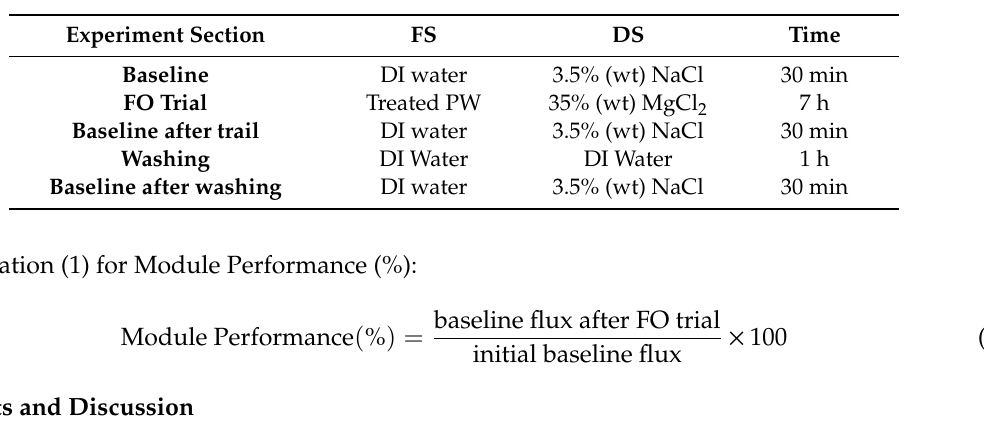
Table 2. Experimental conditions for the five-part experimental series to evaluate the performance of the forward osmosis (FO)